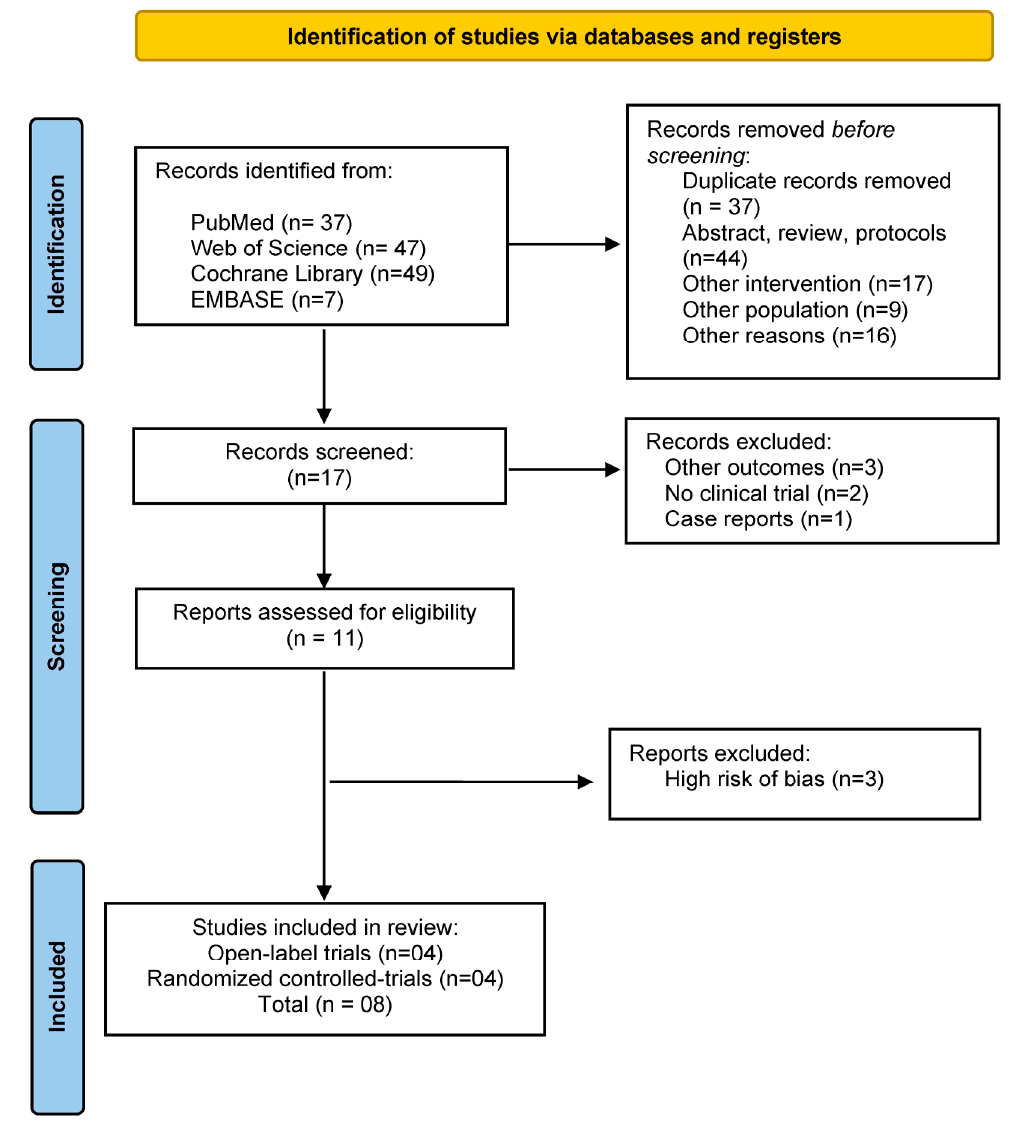
Figure 1. Flowchart of the study selection process.